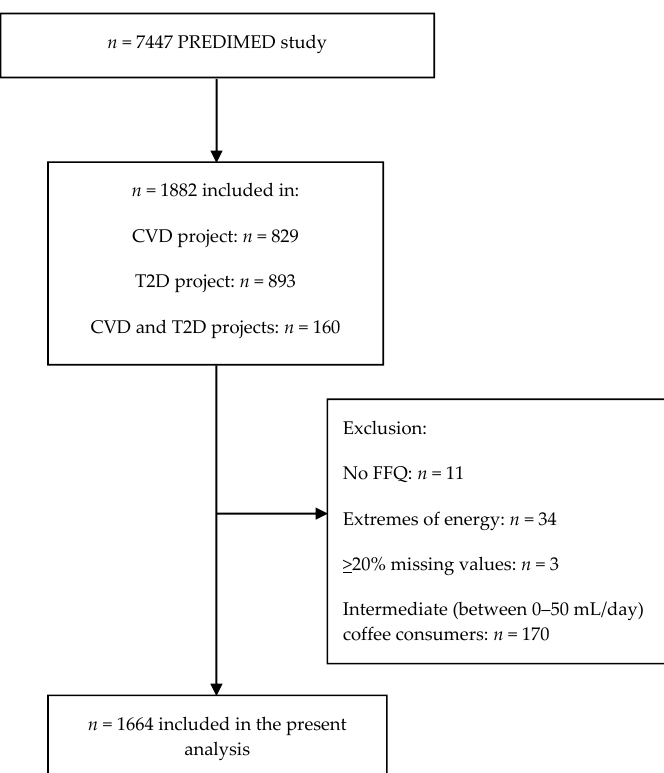
Figure 1. Flowchart of study participants. *, Extremes of energy are defined as out of the range 800–4000 Kcal / day in males and 500–3500 Kcal / day in females. Abbreviations: CVD, cardiovascular disease; FFQ, food frequency questionnaire; T2D, type 2 diabetes.